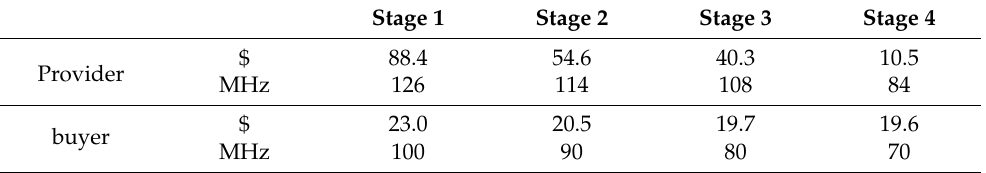
Table 1. 600 MHz incentive auction in